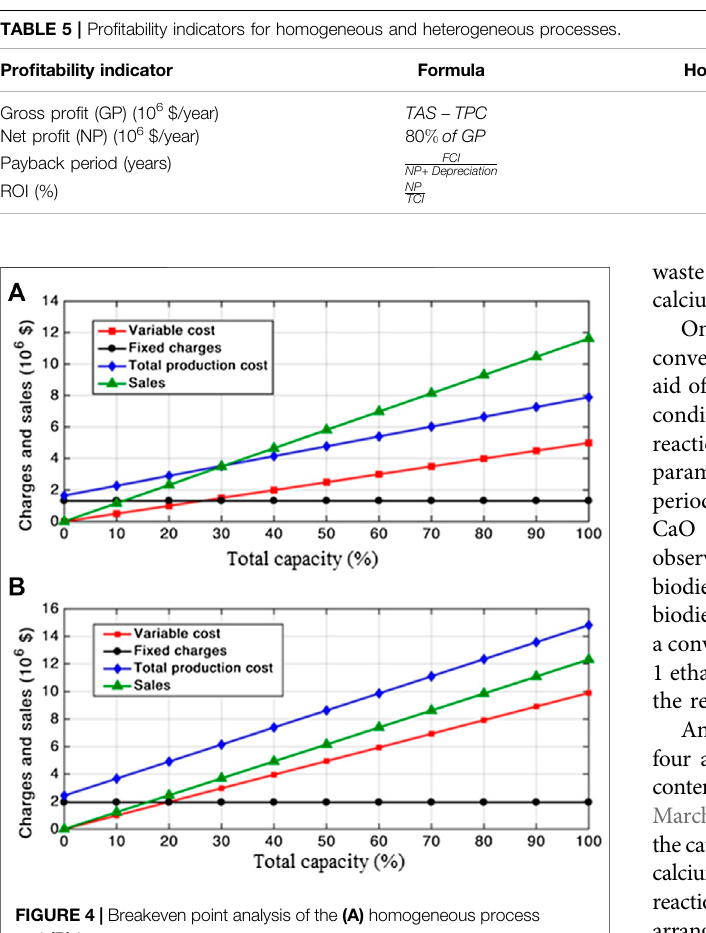
FIGURE 4 | Breakeven point analysis of the (A) homogeneous process and (B) heterogeneous process.